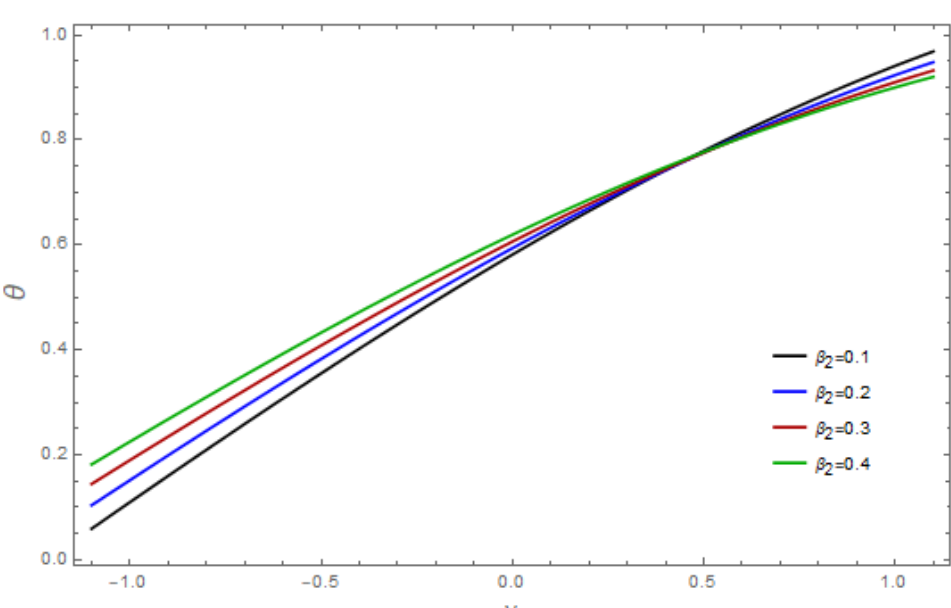
Figure 14. Effect of 𝛽 2 on 𝜃 .